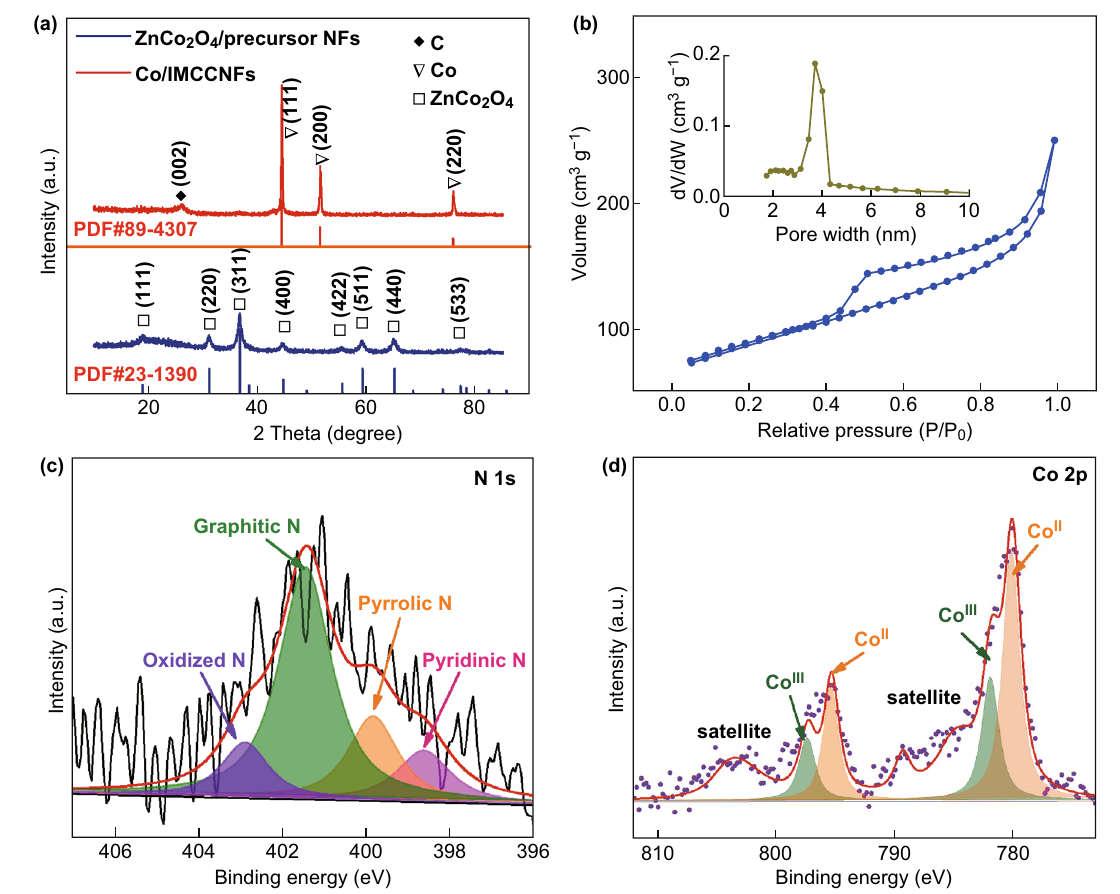
Fig. 3 a Powder XRD pattern of the ZnCo 2 O 4 /precursor NFs and Co/IMCCNFs. b N 2 adsorption and desorption isotherms of the Co/IMCCNFs (inset: pore size distribution of the Co/IMCCNFs). c N 1 s and d Co 2 p XP spectra of the